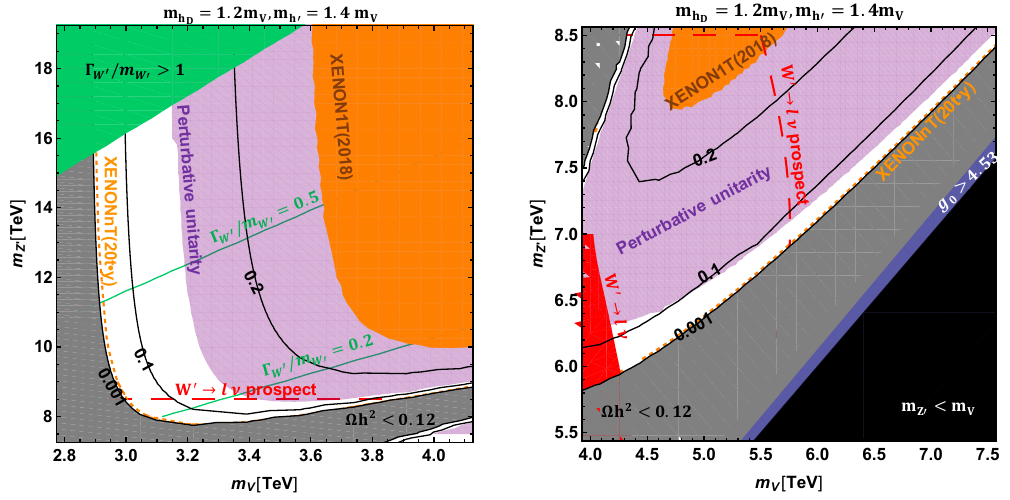
Figure 6 . Combined results in the m V - m Z 0 plane. The gray shaded region cannot explain the whole abundance and the black shaded region is theoretically forbidden. The orange region is already constrained by the XENON2018 and the dotted line shows the prospect by XENONnT (20 ton (cid:1) year). In the purple region, some of the Higgs quartic couplings are non-perturbative. The red shaded region is constrained by ATLAS and the red dashed line shows the prospect. In the left panel, the green line shows the value of (cid:0) W 0 =m W 0 , and (cid:0) W 0 > m W 0 in the green shaded region. In the right panel, g 0 is beyond the perturbative unitarity bound in the blue shaded region.